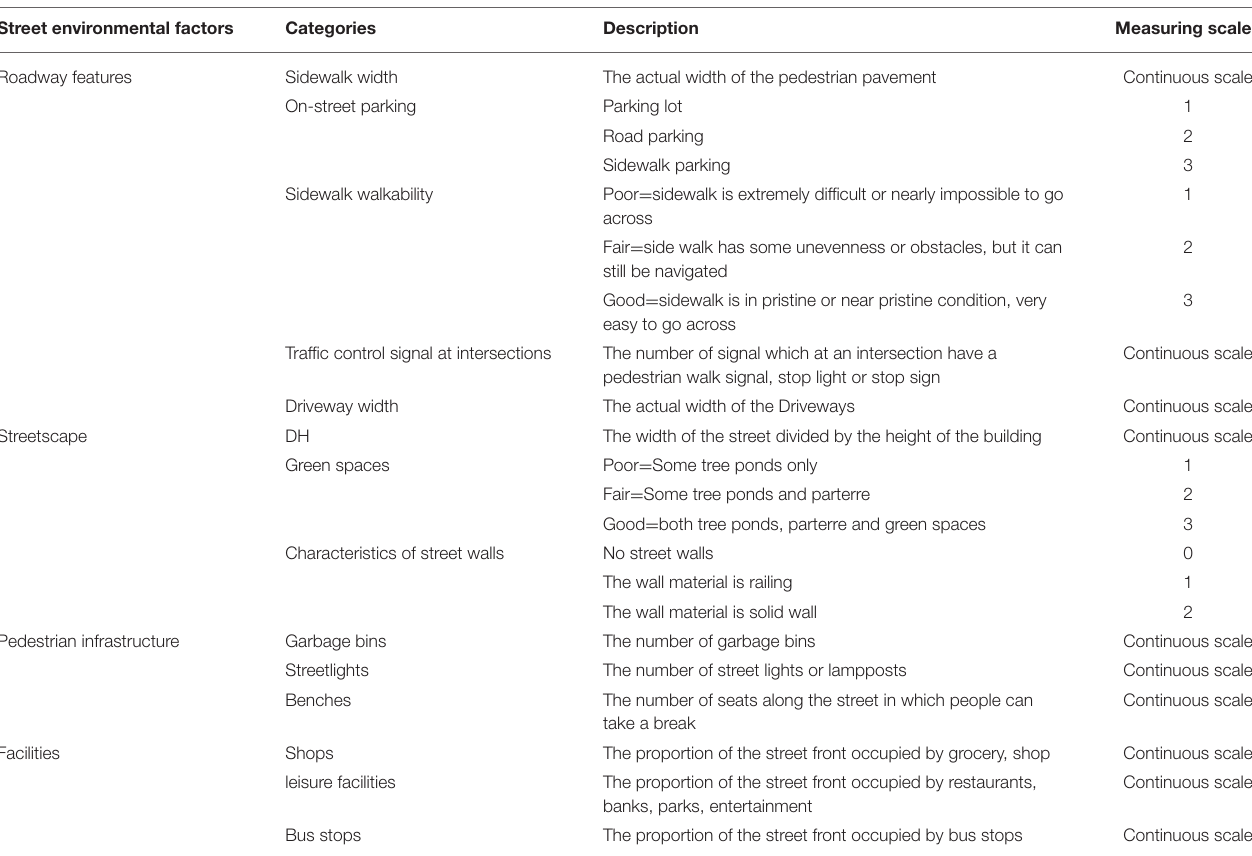
TABLE 1 | Categories and description of the street environment tool used to collect